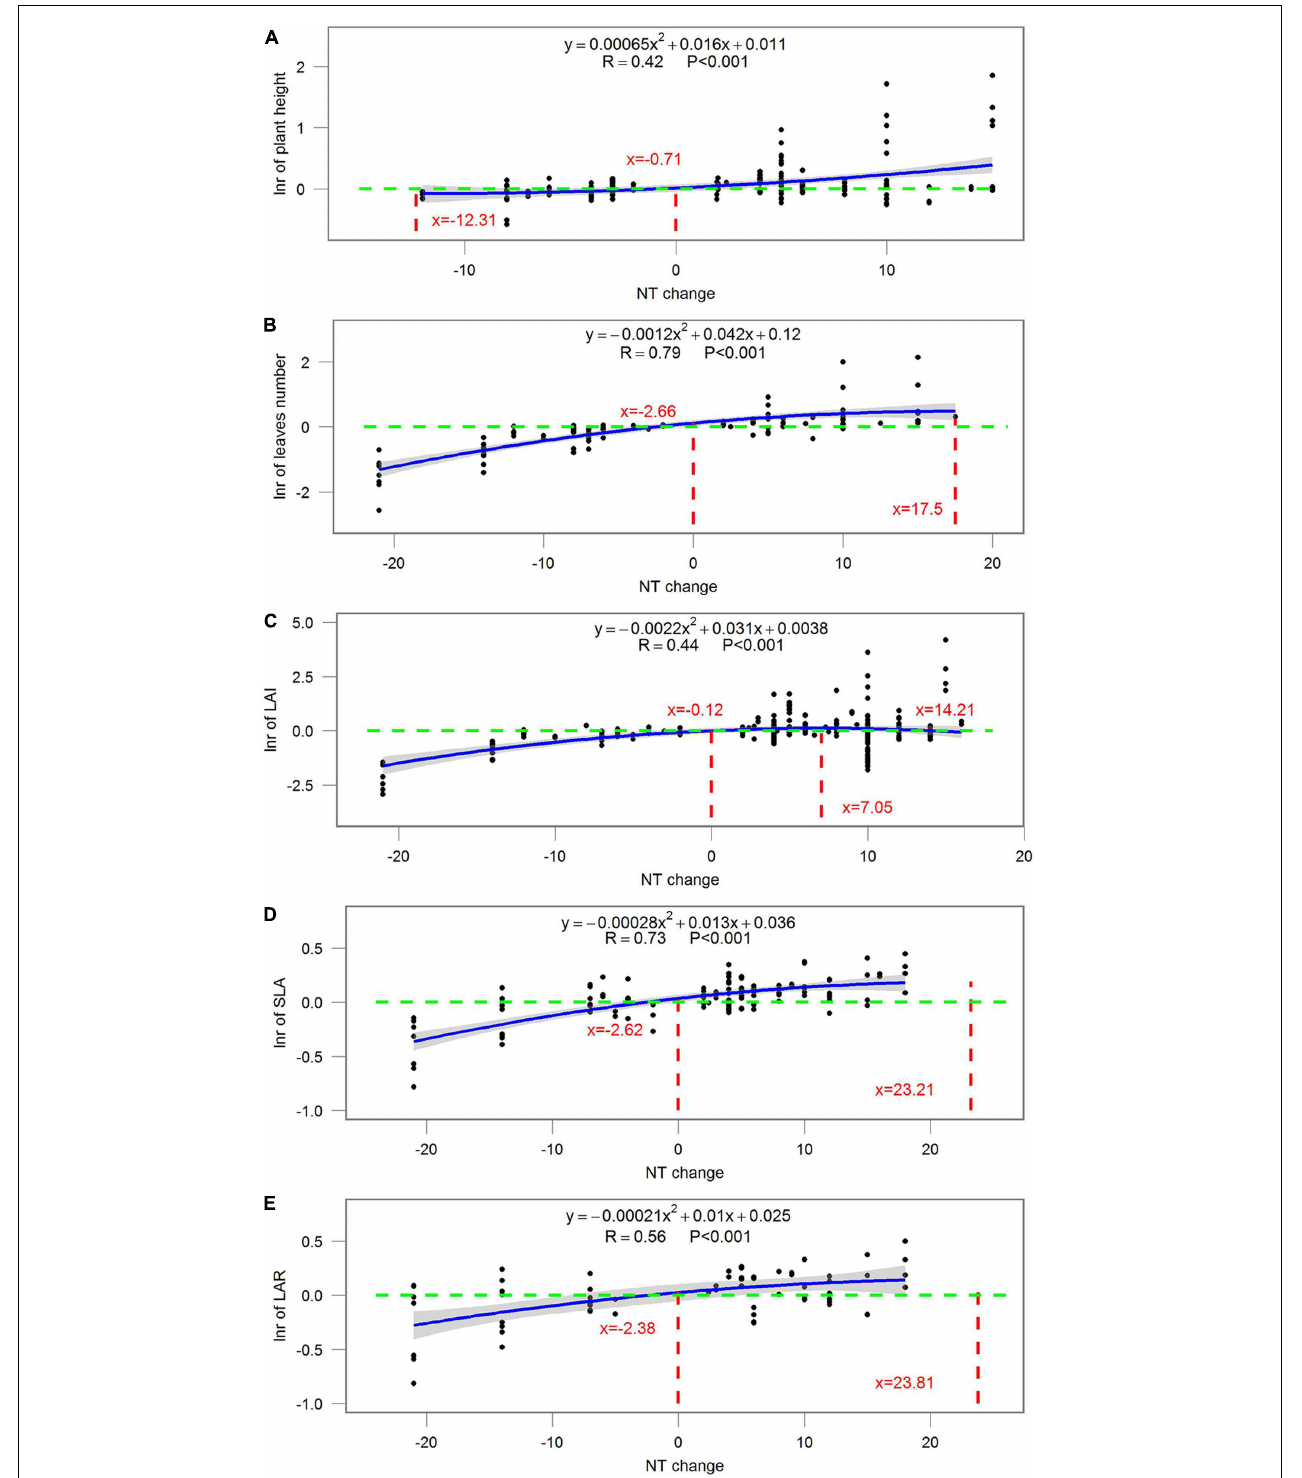
FIGURE 8 | Correlations between the magnitude of NT treatment and the response ratio of (A) plant height; (B) number of leaves; (C) leaf area index (LAI); (D) specific leaf area (SLA); (E) leaf area ratio (LAR). Each point represents response ratio (lnr) to HNT or LNT. Regression function, variation coefficient and p -value are presented in the middle of each graph. Different lines indicate X = 0 (red line), x -value when y is the maximum, crossing points of y = 0 (green line) and regression relationships.